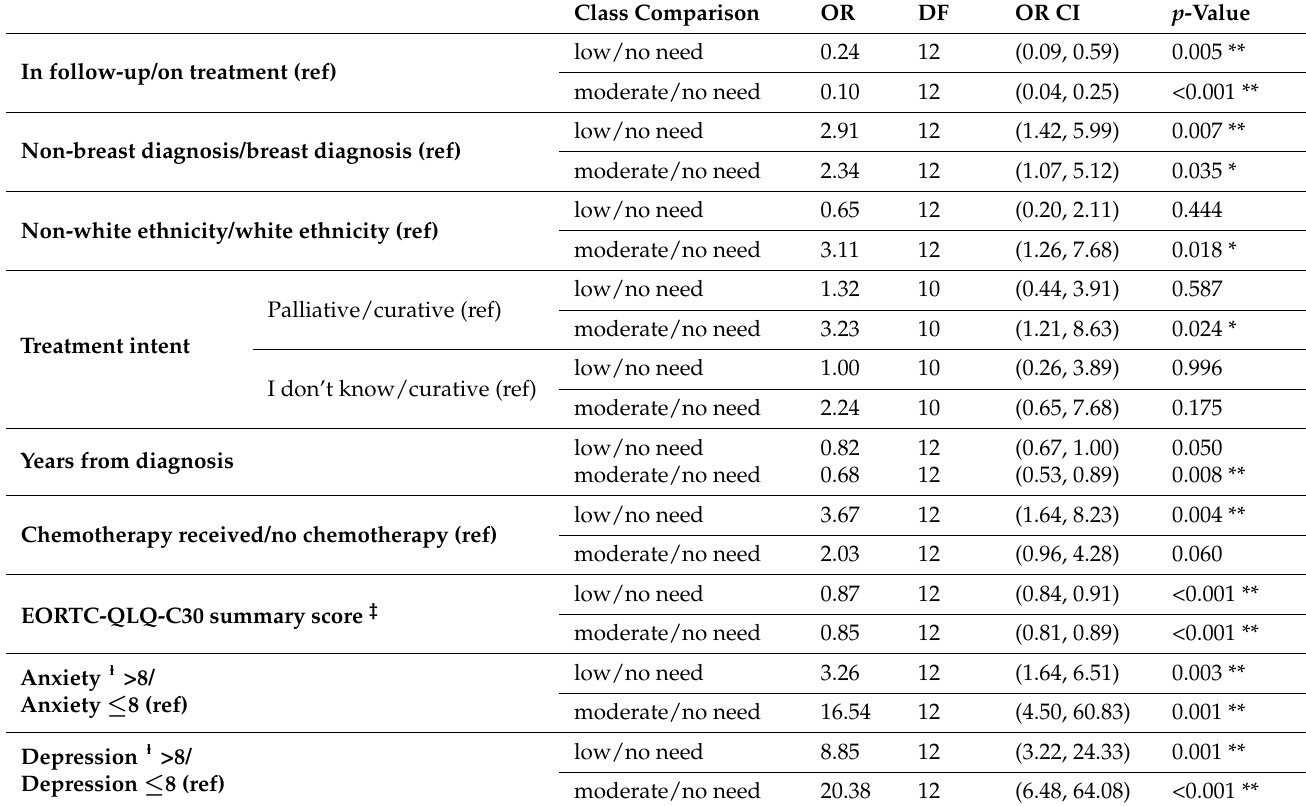
Table 5. Univariable models with covariates significantly associated with level of supportive care need. Class